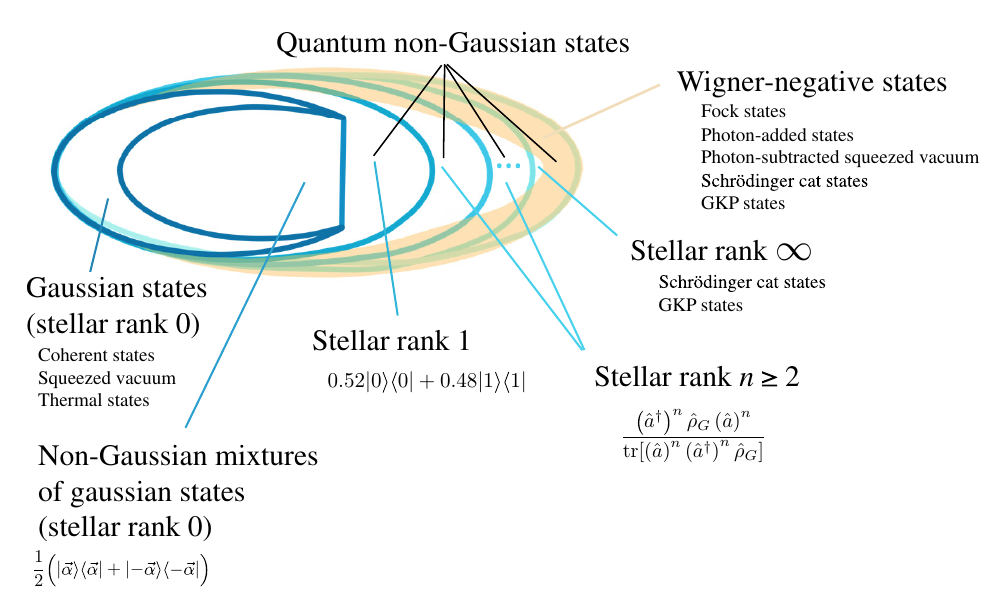
FIG. 1. Overview of the different types of non-Gaussian states that can be found in state space. The different aspects will all be considered throughout Sec. III. Here we attempt to show the stellar hierarchy and how it differentiates itself from the convex hull (mixtures) of Gaussian states. Furthermore, we emphasize that the stellar rank and Wigner negativity are different quantifiers of non- Gaussianity. It should be noted that all non-Gaussian pure states are Wigner-negative states, but we can find states that are not mixtures of Gaussian states without Wigner negativity. For all the classes, we provide examples of states that belong to this group, the Wigner functions for several of these examples are shown in Fig.